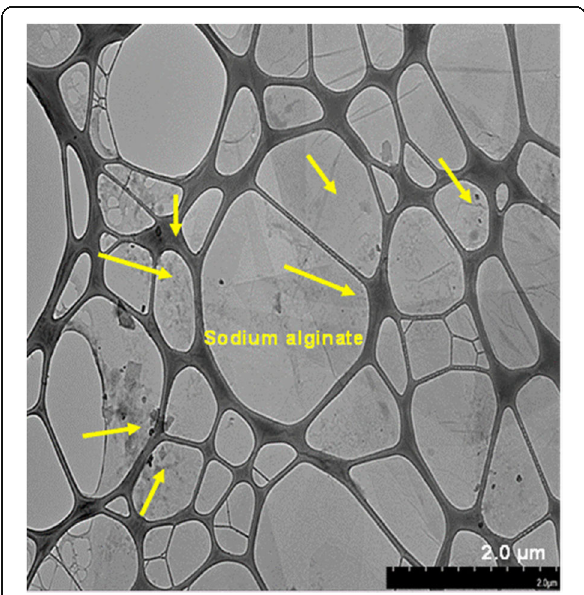
Fig. 5 TEM image of SGO nanosheets distributed in sodium alginate polymer